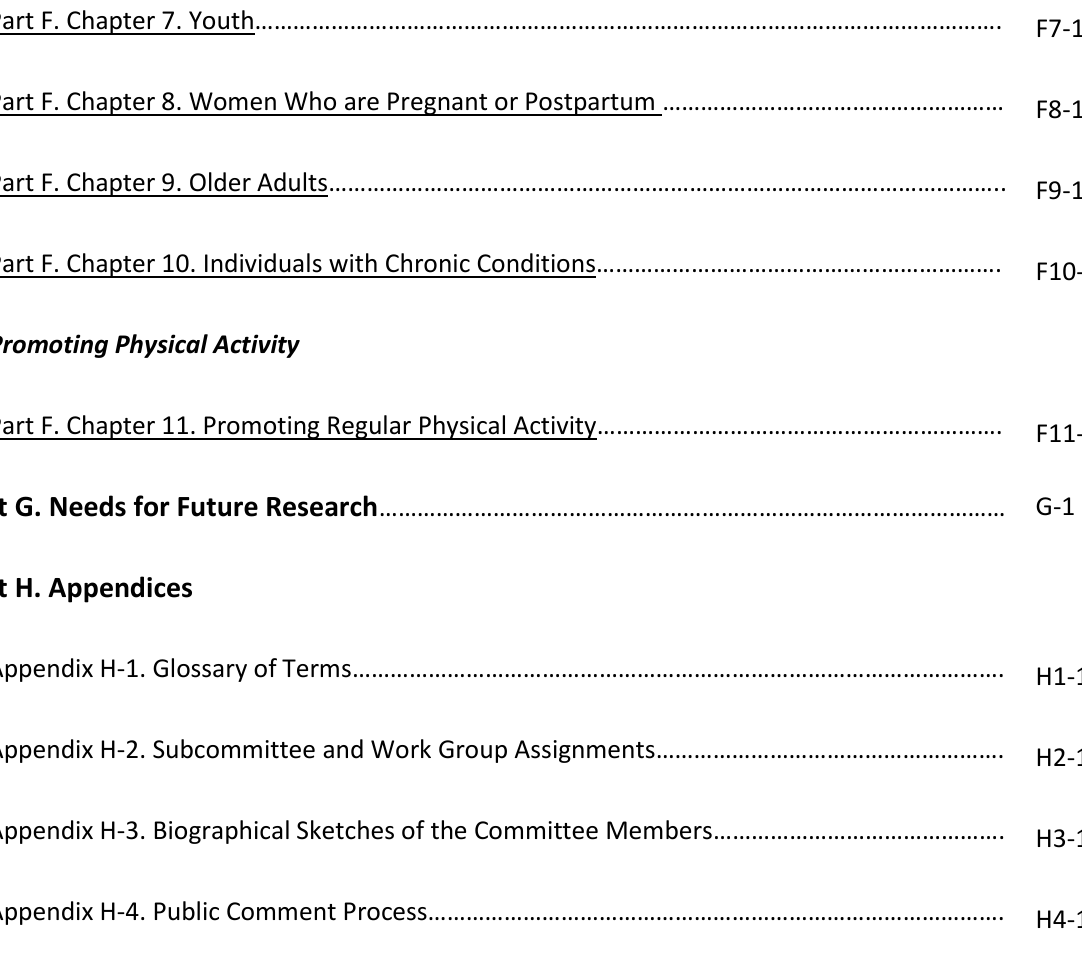
Physical Activity Considerations for Selected